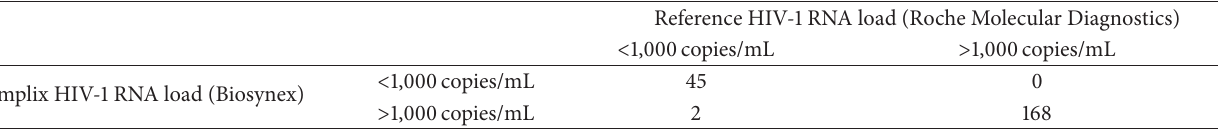
Table 5: Detection of virological failure, that is, HIV-1 RNA load above 1,000 copies/mL according to the WHO [13], by HIV-1 RNA-based Amplix real-time PCR assay and the reference COBAS AmpliPrep/COBAS TaqMan HIV-1 test v2.0 in 215 HIV-seropositive clinical plasma samples from antiretroviral drug-experienced patients m . Reference HIV-1 RNA load (Roche Molecular Diagnostics) < 1,000copies/mL > 1,000 copies/mL < 1,000 copies/mL 45 Amplix HIV-1 RNA load (Biosynex)